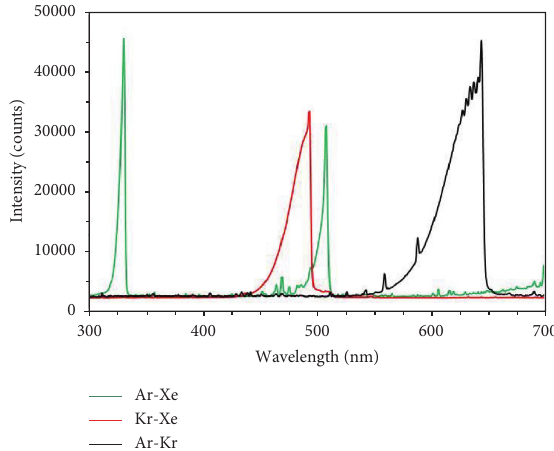
670.8Kr 760.2 Li Li 610.4 Figure 8: Emission spectra of gas mixtures at a temperature of Figure 6: Dependence of the intensity of krypton and lithium lines 413K Ar-Xe, Kr-Xe-F � 10 14 n/cm 2 s, Ar-Kr-5 ∙ 10 13 n/cm 2 s. Inte- in Ar-Kr mixture on the temperature of the lithium layer, gration time: Ar-Xe-1 s Kr-Xe-100 ms, Ar-Kr-3s. F � 10 14 n/cm 2 s. The intensity of krypton lines increased by 5